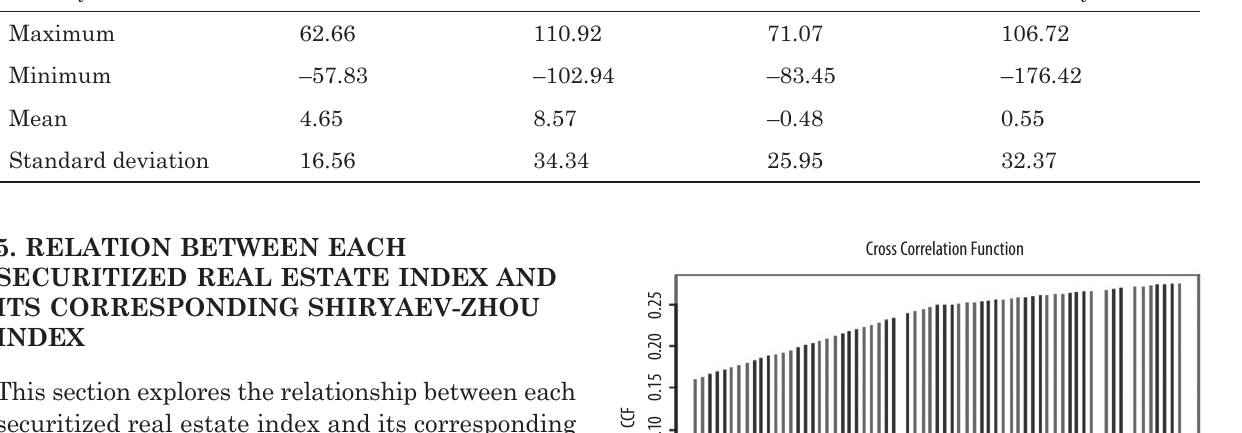
Table 1. Descriptive statistics of the Shiryaev-Zhou indices of securitized real estate indices of the four countries Country